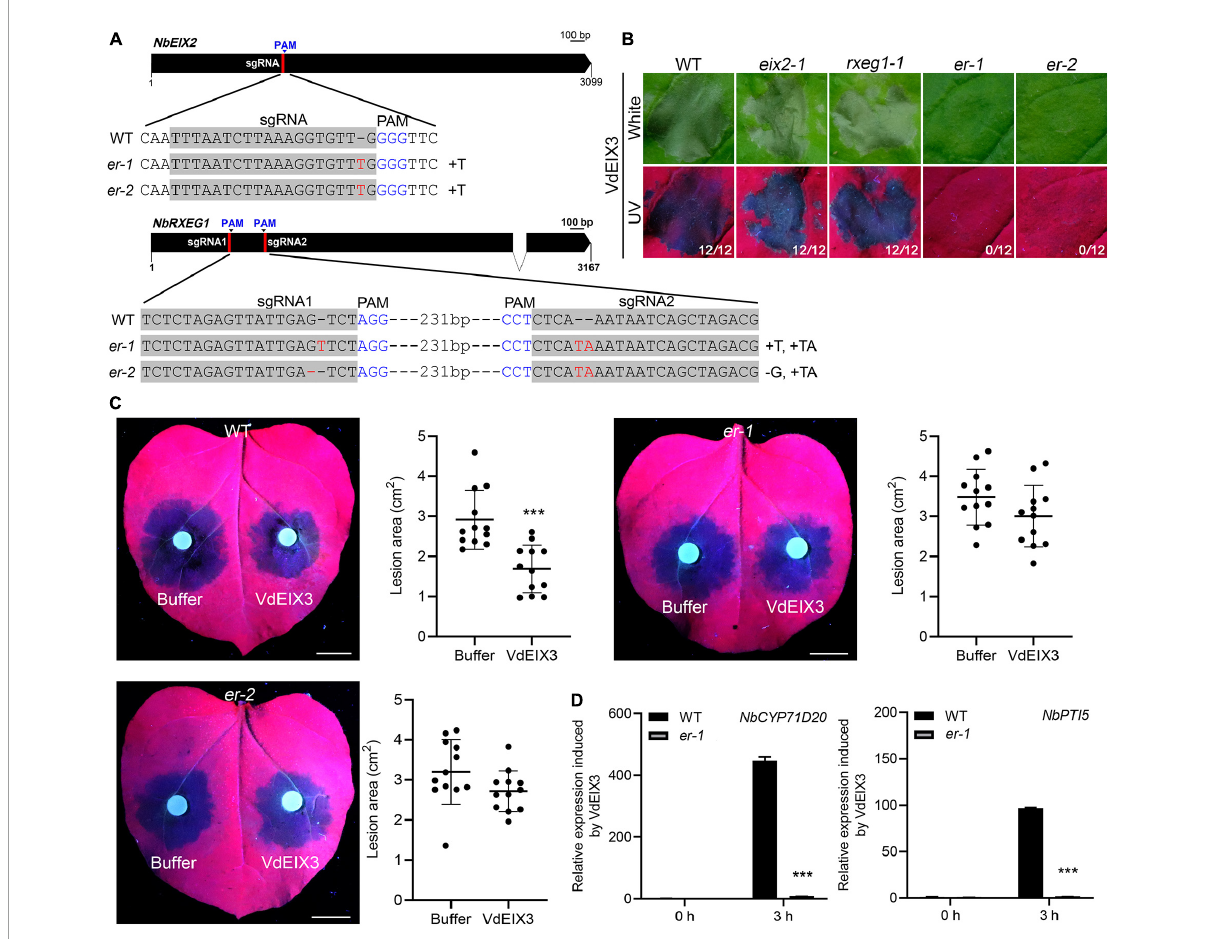
FIGURE5 The eix2 rxeg1 double mutants are greatly impaired in regulating VdEIX3-triggered immunity. (A) Sequence alignment of the regions in eix2 and rxeg1 targeted by sgRNAs. er indicates eix2 rxeg1 double mutant. (B) VdEIX3 fails to induce cell death in er mutants by agroinfiltration. The photos were taken 3 days post infiltration under white and UV light, respectively. (C) VdEIX3 protein fails to promote resistance to Phytophthora capsici in er mutants. Bars, 1 cm. Data are shown as mean ± SD (Student’s t -test, *** P < 0.001). (D) Expression of NbCYP71D20 and NbPTI5 induced by VdEIX3 protein was greatly reduced in the er-1 mutant. Data are shown as mean ± SD (Student’s t -test, *** P <